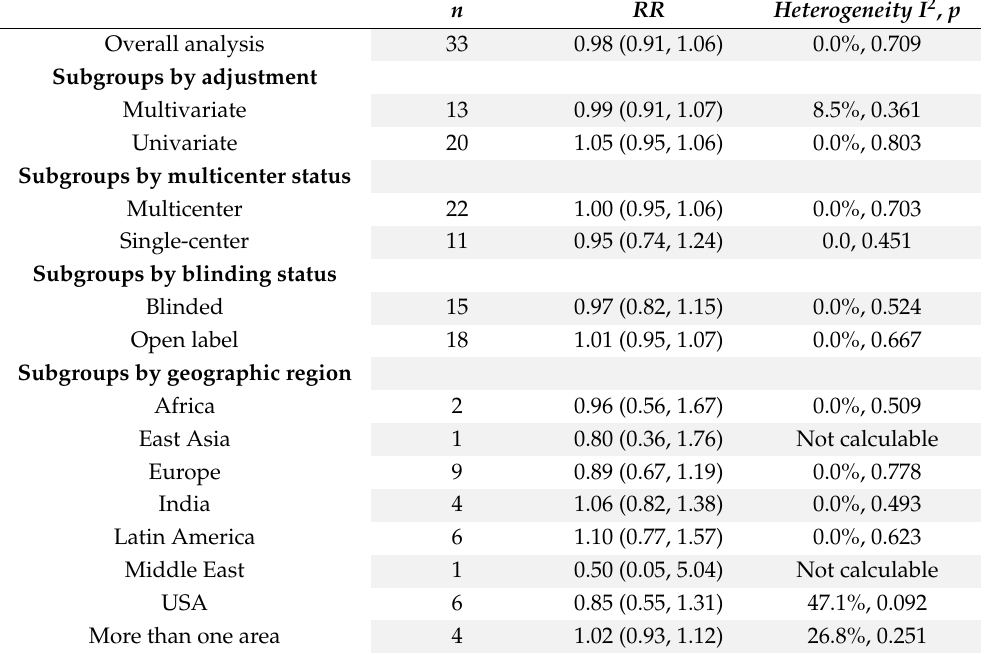
Table 3. Results of the meta-analyses examining the association between convalescent plasma therapy and mortality (28-day); subgroup analyses by adjustment, multicenter status, blinding status and geographic region are presented.